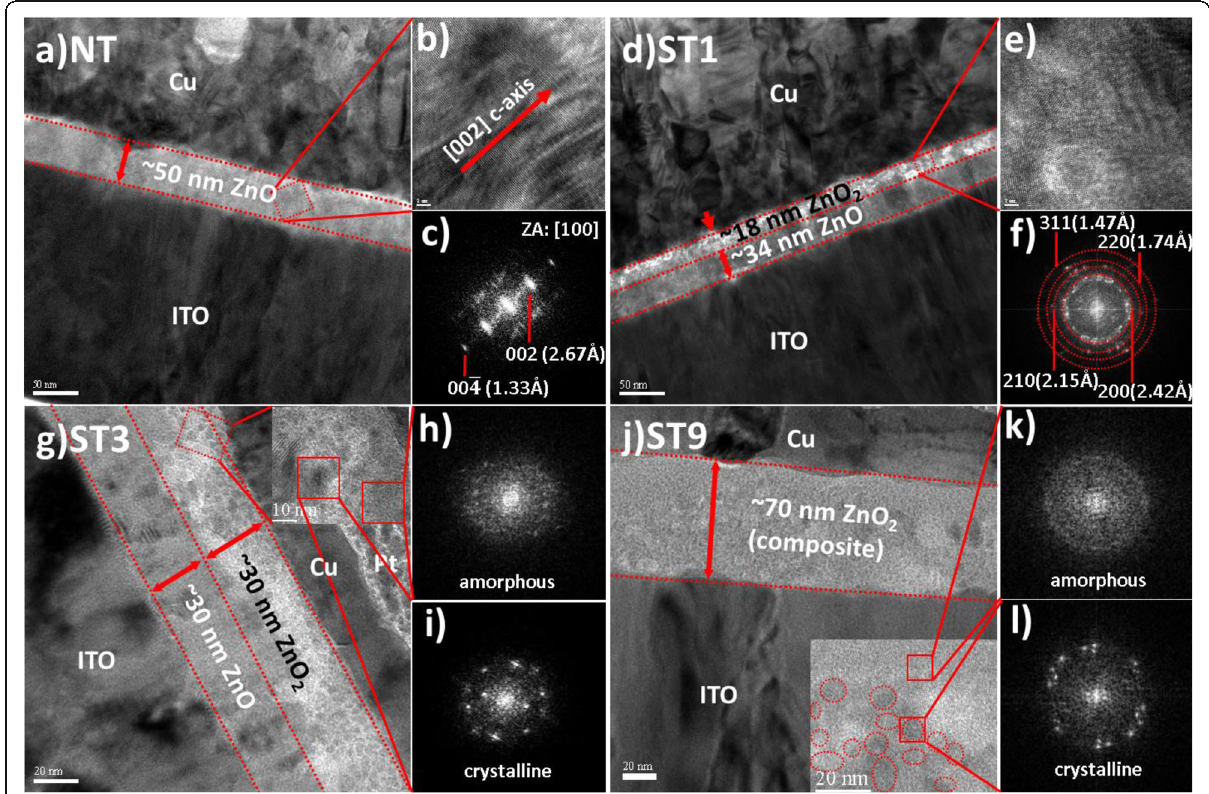
Fig. 1 TEM analysis of ( a – c ) control, ( d – f ) ST1, ( g – i ) ST3, and ( j – l ) ST9 layers. The inset in ( g ) and ( j ) are high-resolution TEM images of ST3 and ST9,